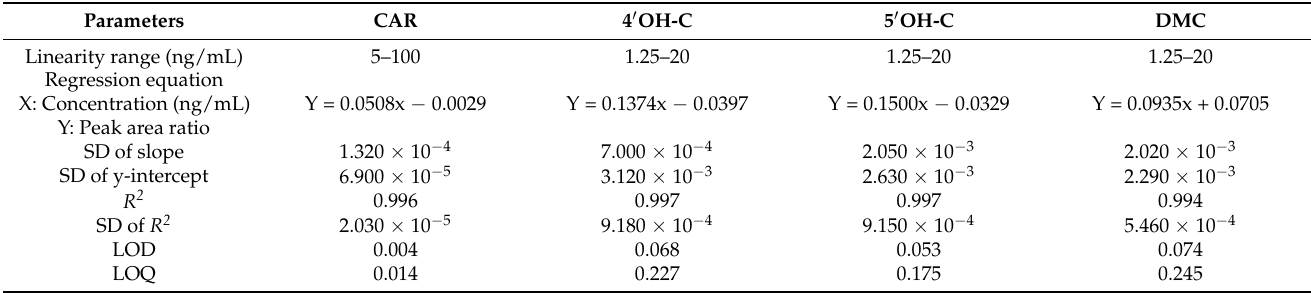
Table 2. Selected assay validation